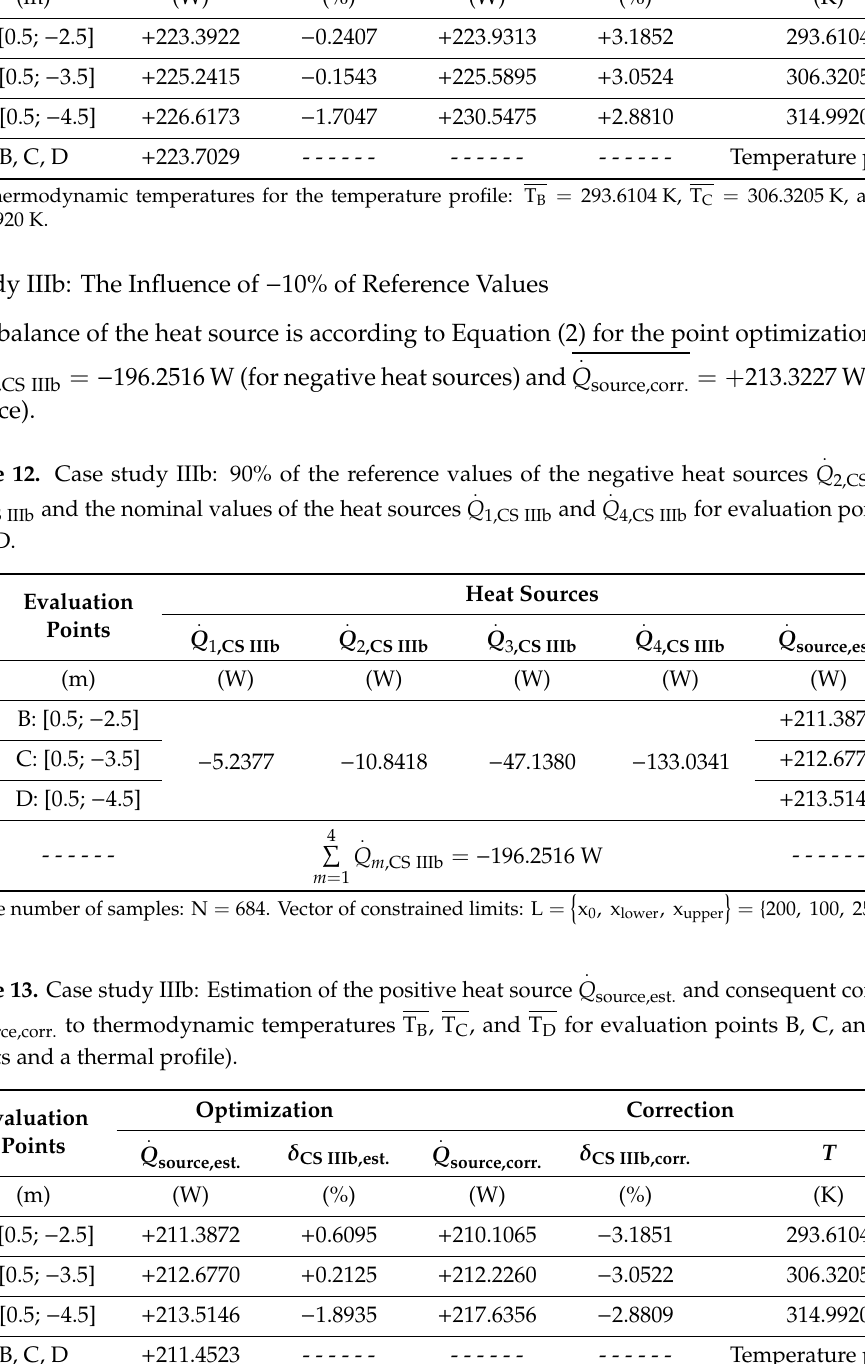
. Q source,est. and consequent corrections